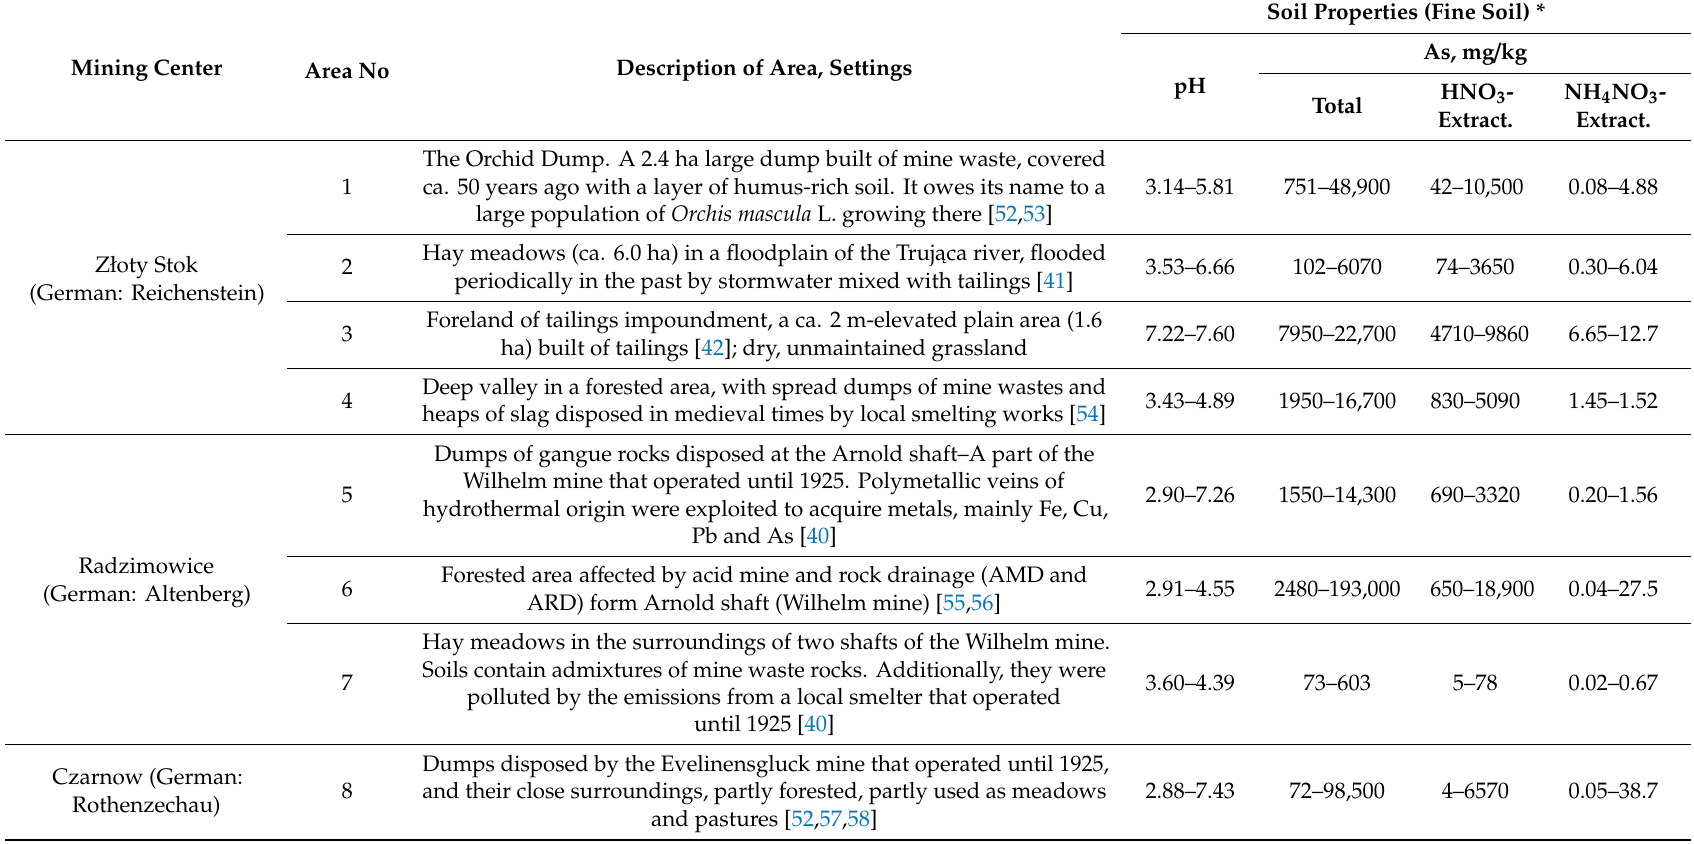
Table 1. Description of experimental areas and basic soil